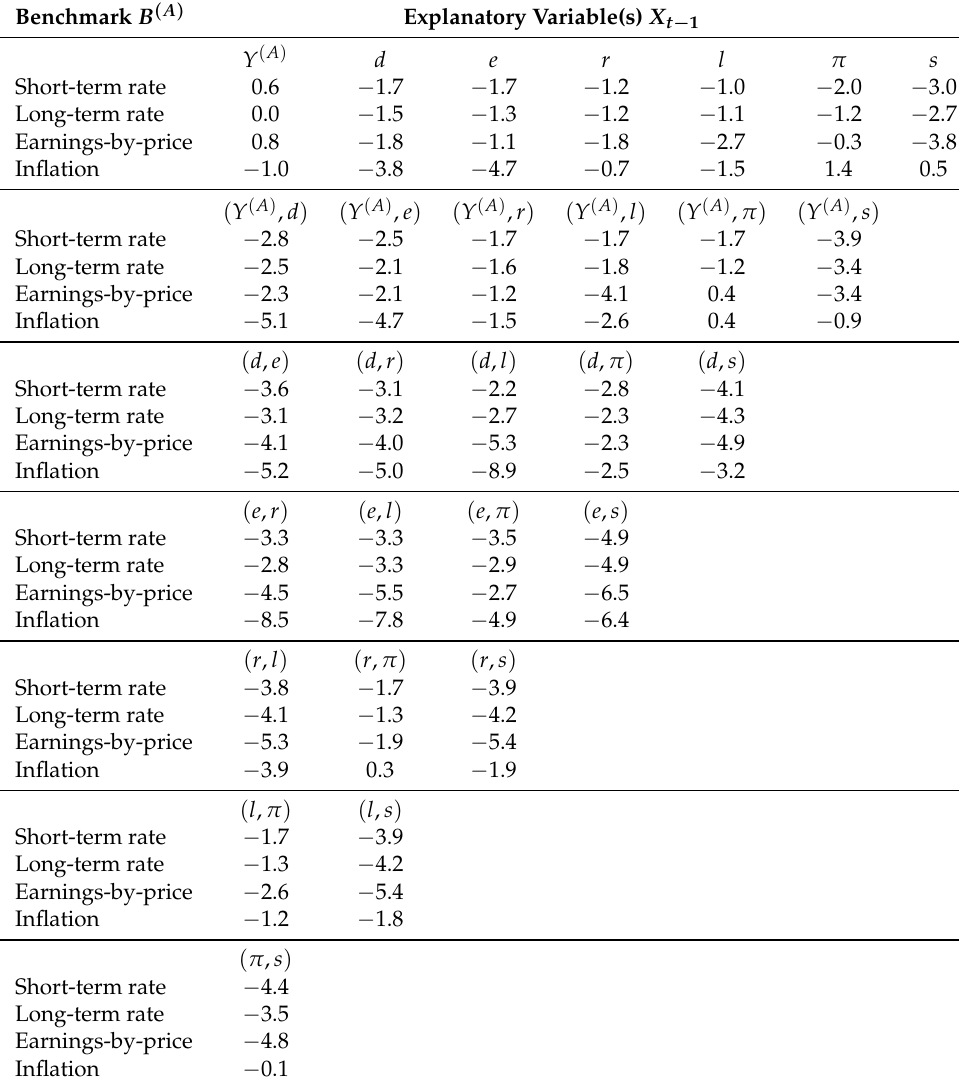
Table 3. Predictive power for the variance of five-year excess stock returns Z approach. The prediction problem is defined in (5). The same predictive variables X t − 1 are used in the predictions for the conditional mean and variance function. Additional notes: see Table